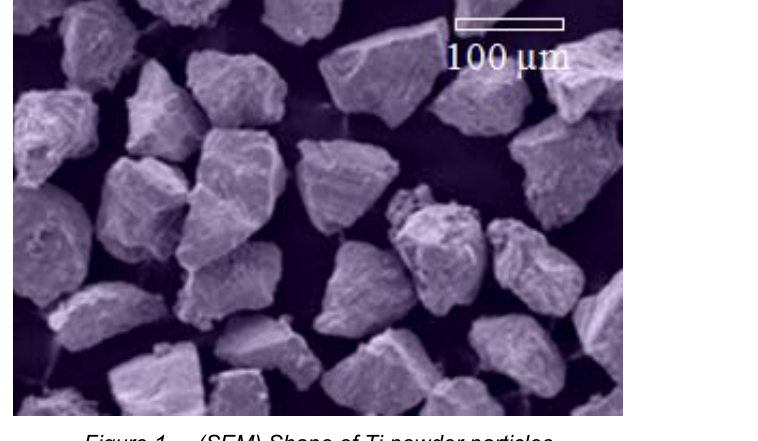
Figure 1 – (SEM) Shape of Ti powder particles Рис . 1 – (SEM) Форма частиц порошка Ti